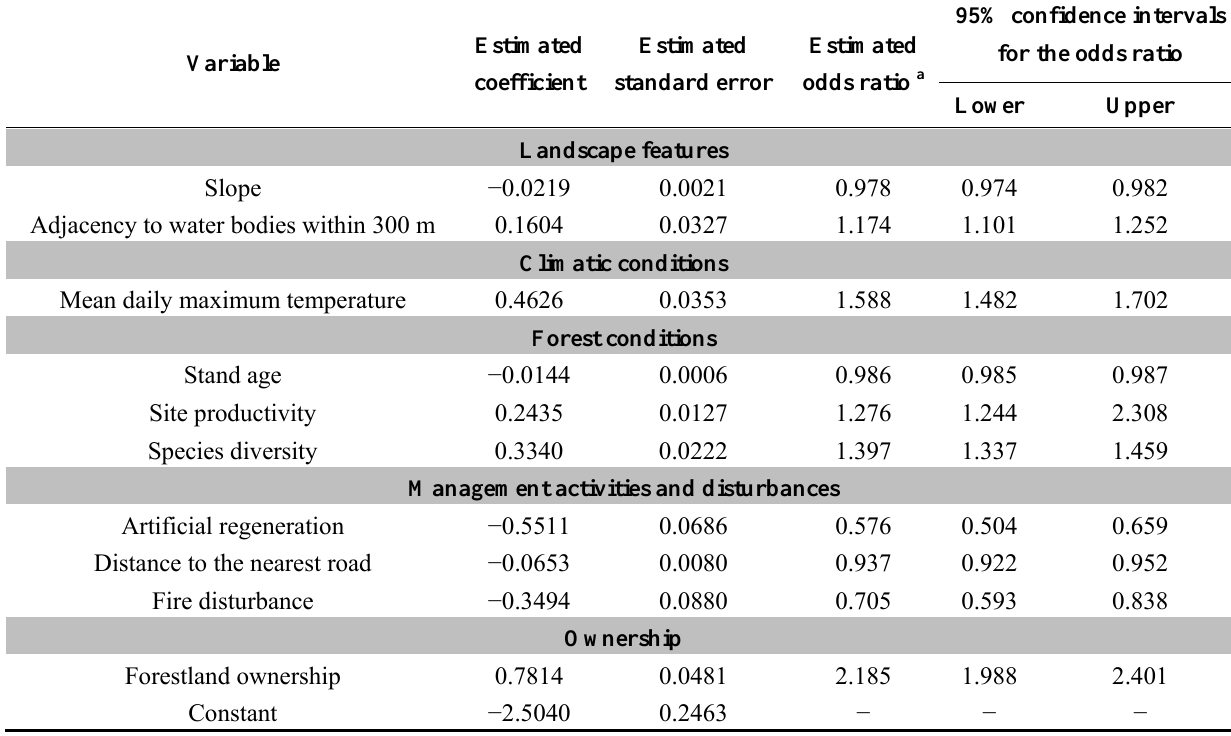
Table 2. Potential determinants of L. japonica invasion of forested plots in the southern United States as indicated by results of stepwise multiple logistic